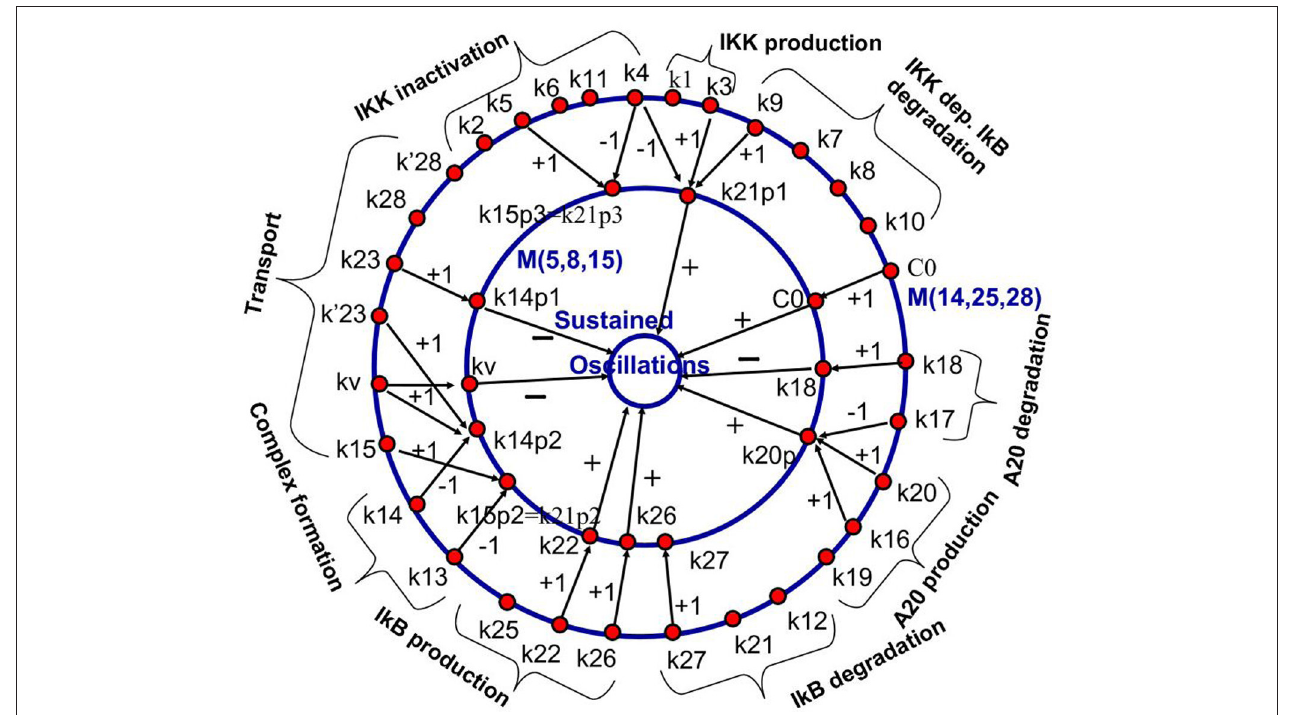
FIGURE 7 | Backward pruning strategy. The model M ( 14 , 25 , 28 ) from Radulescu et al. (2008) (first proposed in Lipniacki et al. (2004), see also BIOMD0000000226 in Biomodels database) was used to generate a hierarchy of simpler models, the simplest one being M ( 5 , 8 , 15 ) . We show the mapping between the parameters of the models M(14, 25, 28) and M(5, 8, 15). Parameters of the first model are gathered into monomials that are